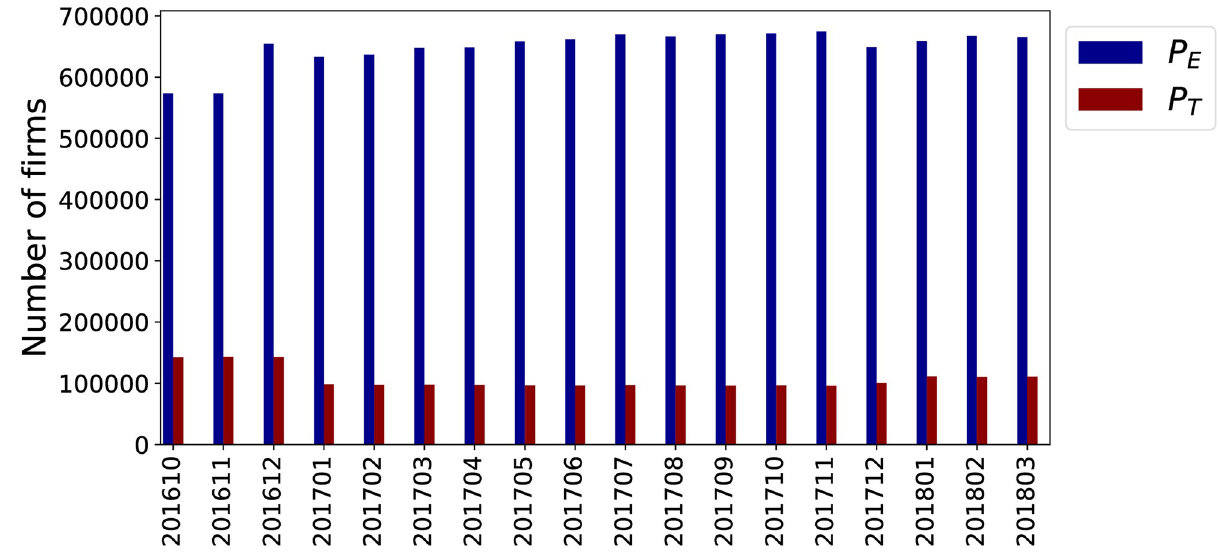
Fig 1. Size of the target perimeter P T and the extended perimeter P E across